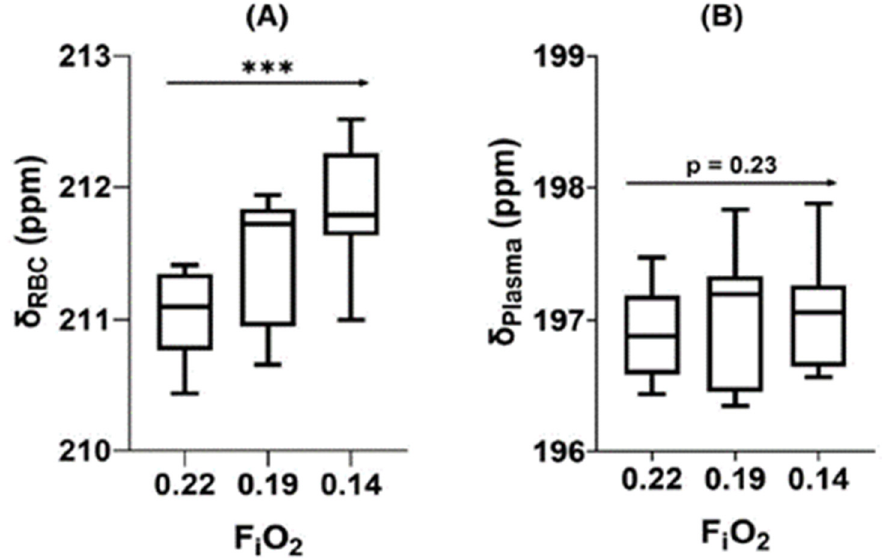
Figure 15. Measurements of 129 Xe chemical shift in vascular blood in a healthy rat shows an increase in the chemical shift of the RBC peak as the FiO2 is lowered and hemoglobin oxygen saturation is reduced. This trend is opposite of that observed in human blood [57] but is consistent with the frequency shift observed between oxygenated and deoxygenated mouse blood in vivo, despite the unresolved RBC peak. *** = p < 0.001. Reprinted with permission from Friedlander, et al. ( Magn Reson Med 2021, ref. [58]).